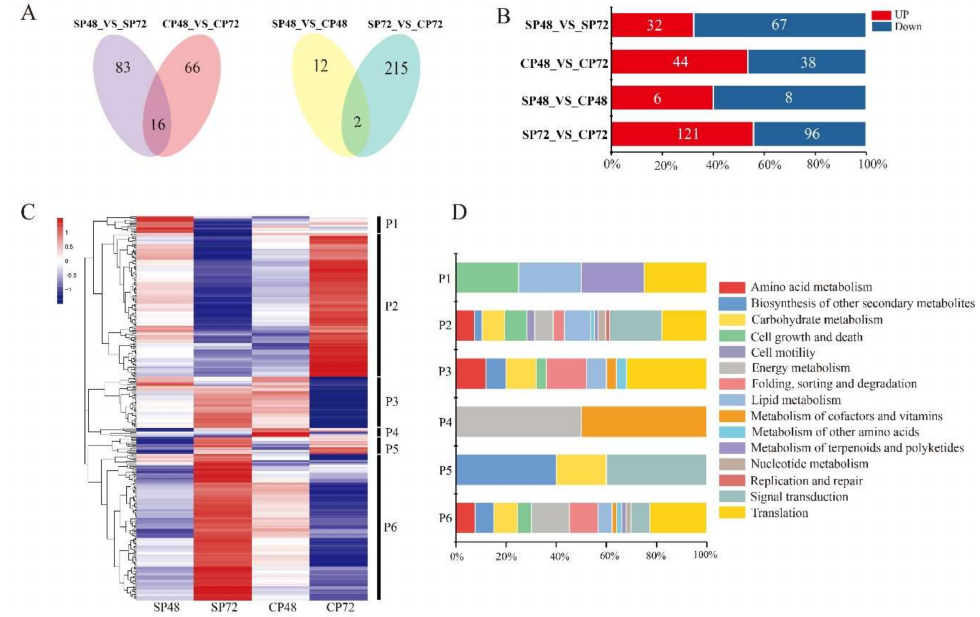
Figure 6. Di ff erentially expressed proteins (DEPs) analysis of C. oleifera after self- and cross-pollination. ( A )VenndiagramsofDEPsinself-andcross-pollinatedpistilsat48and72hours. SP48 / 72, self-pollinated pistils at 48 h / 72 h and CP48 / 72, cross-pollinated pistils at 48 h / 72 h. ( B ) Numbers of DEPs in self- and cross-pollinated pistils. ( C ) Hierarchical clustering analysis of 295 DEPs after self- and cross-pollination of C. oleifera . DEPs clustered into six groups (P1–P6). ( D ) Stacked bar chart of classification of KEGG pathway in six groups. The X-axis represents the proportion of each class in the corresponding